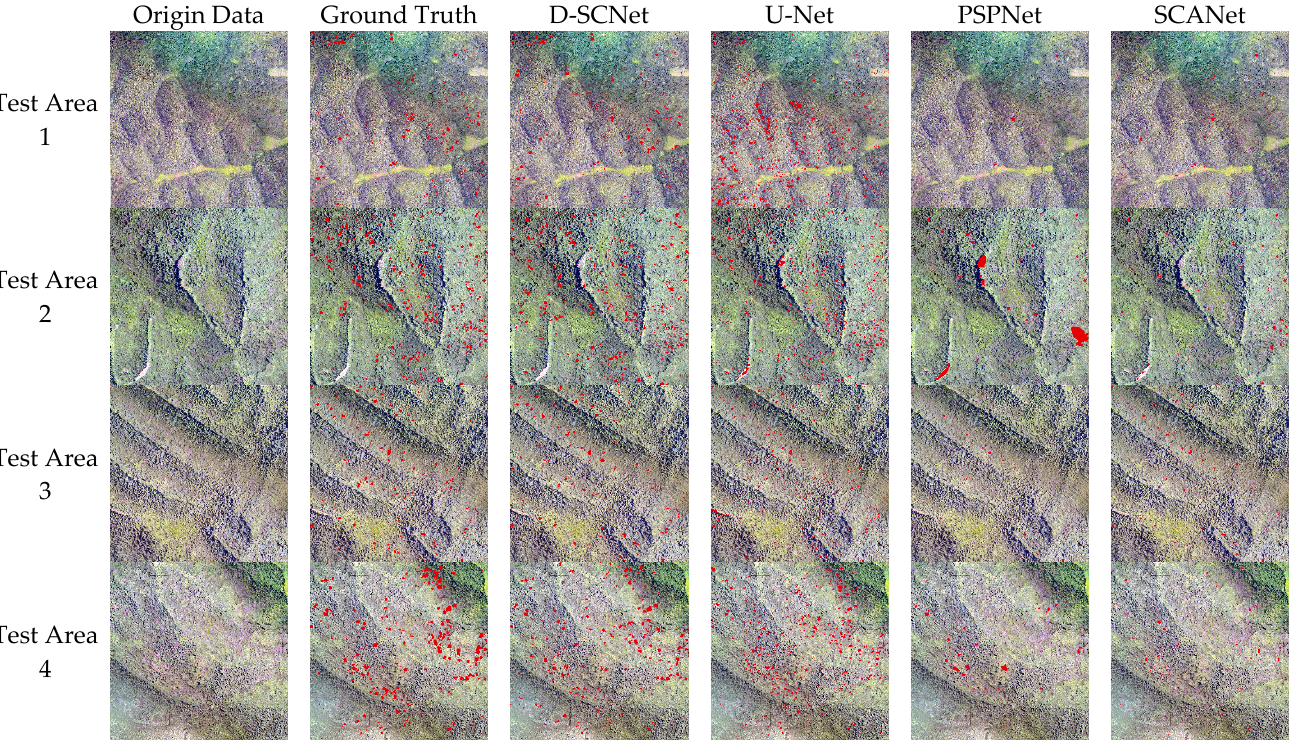
Figure 13. Test results of other comparison methods. Table 5. The accuracy identification using other comparison methods.